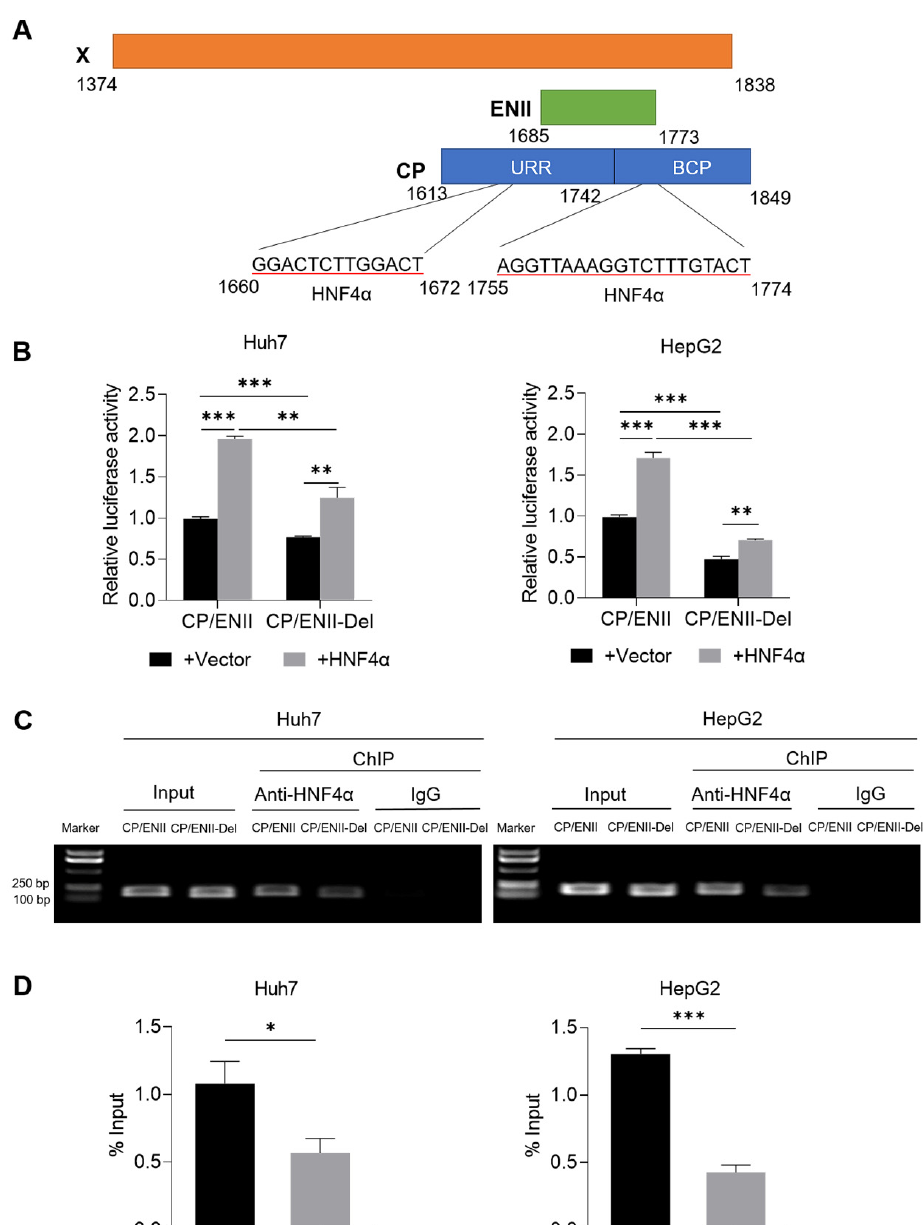
Figure 5. The effect of the nt1755–1772del on HBV CP/ENII transcriptional activity. ( A ) A diagram of the HNF4 α binding sites in the HBV CP/ENII region. ( B ) The pGL3-CP/ENII or pGL3-CP/ENII-